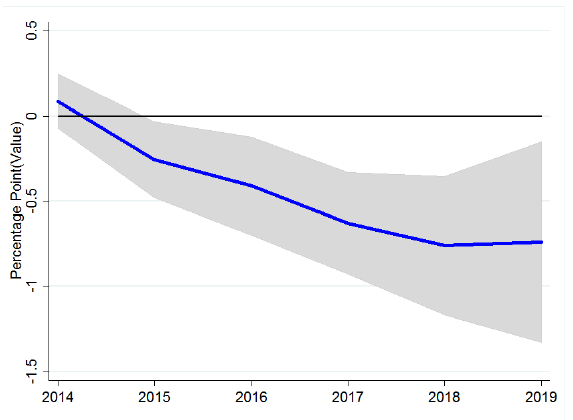
Figure 2. Cumulative Response of MarketShare to Dummy2014.